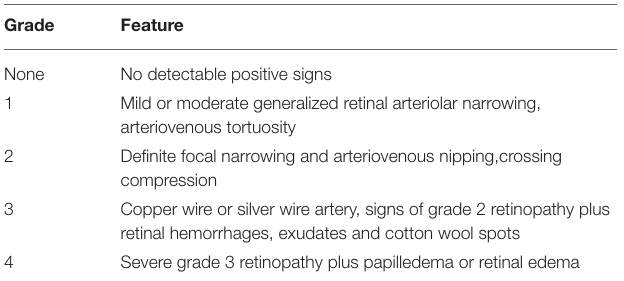
TABLE 1 | The Keith–Wagener–Barker classification system for retinal